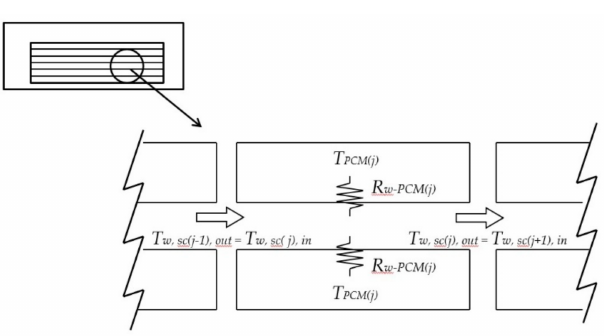
Figure 6. Distribution of the PCM storage tank as considered in the